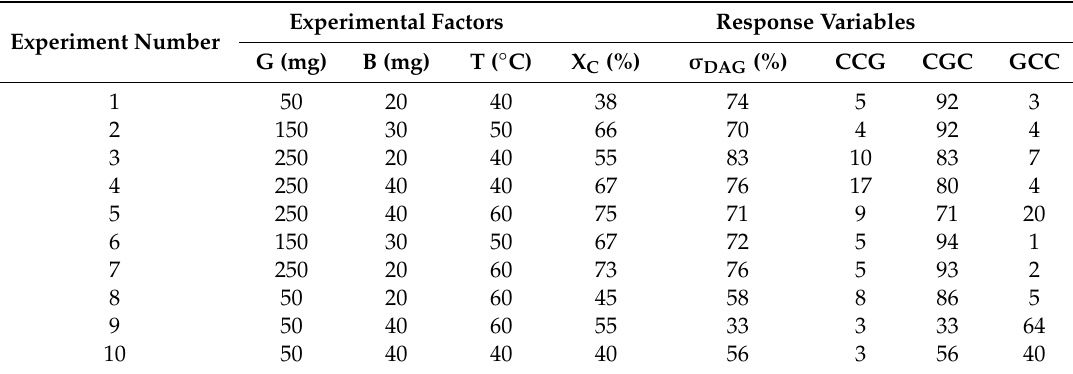
Table 1. Enzymatic synthesis of 1,3-dicaproylglycerol, experimental factors, and responses obtained at 6 hours of